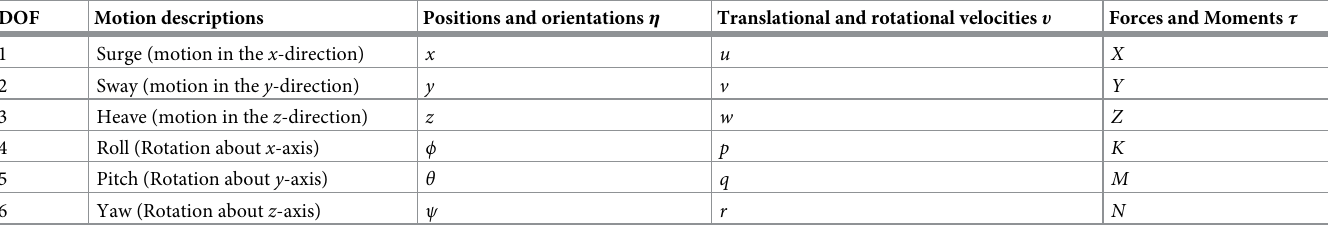
Table 1. Notations used for a